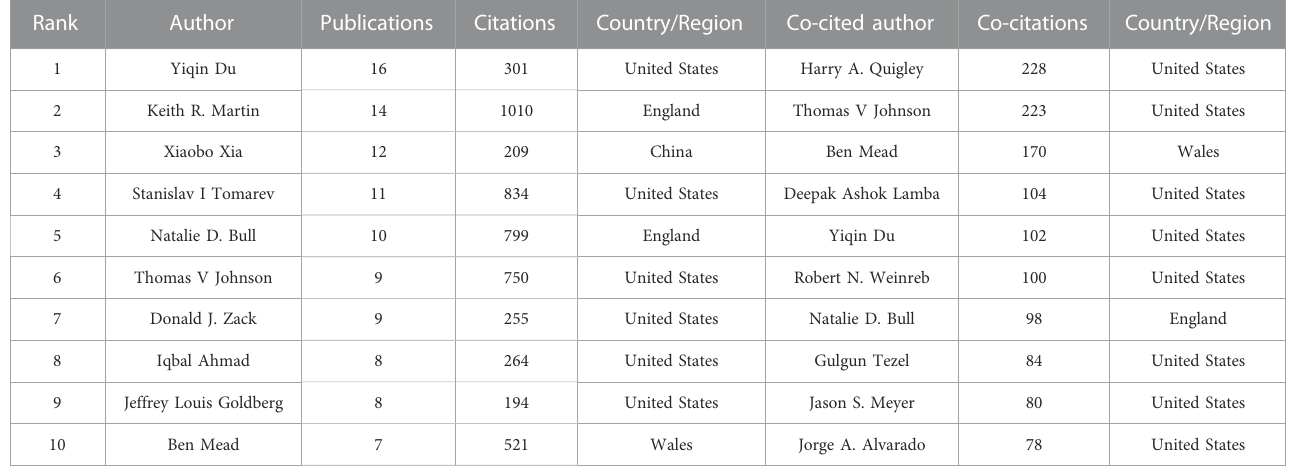
TABLE 1 Top 10 proli fi c authors and co-cited authors about the application of stem cells in glaucoma.